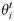
Approximate inference of dynamic neural interactions and macroscopic network properties.Analysis on simulated spike data of 40 neurons. A Top: Simultaneous spiking activity of 40 neurons that are repeatedly simulated 500 times (here only 3 trials are visualized). The data is sampled from a time-dependent model of a neural population (Eq 1). The time-varying parameters are chosen such that neurons’ spike probability resembles evoked activity in response to stimulus presentation to an animal. The neural interactions are assumed to smoothly change irrespective of the firing rates. See the main text for details. Bottom: Empirical spike probability over time, averaged over trials and neurons. B Top: Estimated network states at t = 50, 150, 300 by the pseudolikelihood-Bethe approximation method. Neurons are represented by nodes whose colors respectively indicate a value of the smoothed estimate of θit (for i = 1, …, 40). Links are color-coded according to estimated strength of the interaction θijt between connected nodes (positive or negative interactions are marked in red or blue, respectively). Only significant edges are displayed, where the corresponding θijt has a 98% credible interval that does not include 0. Bottom: Dynamics of 3 exemplary interaction parameters, θijt. The lines denote the ground truth from which the binary data are sampled. The shaded areas are 98% credible intervals. C Estimated population rate (top left). Probability that all neurons are silent (bottom left). Entropy (top right) and heat capacity (bottom right) of the neural population. In all panels, shaded areas indicate 1% and 99% quantiles obtained by resampling the natural parameters from the fitted smoothed distribution. Solid lines represent ground truth computed from the underlying network model.